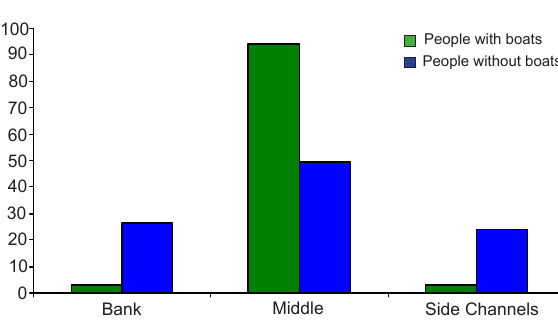
Figure 3. Modes and areas of fishing between Narora and